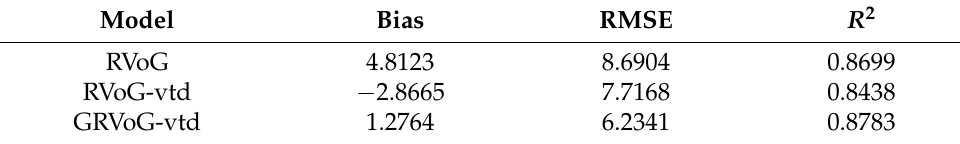
Table 1. Quantitative comparisons of the employed methods with respect to LiDAR